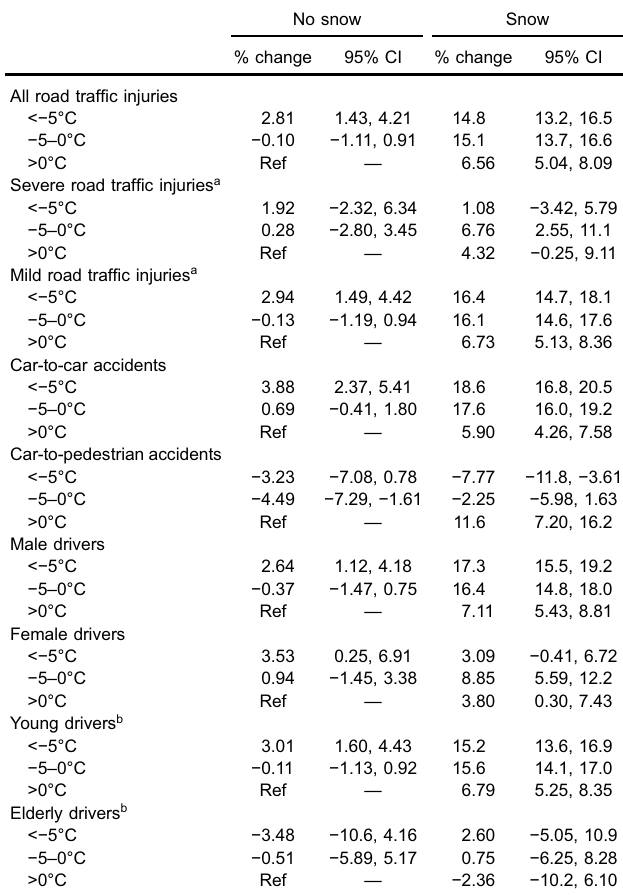
Table 2. Separate effects of temperature and wet conditions on road traf fi c injuries, 2007 to 2011